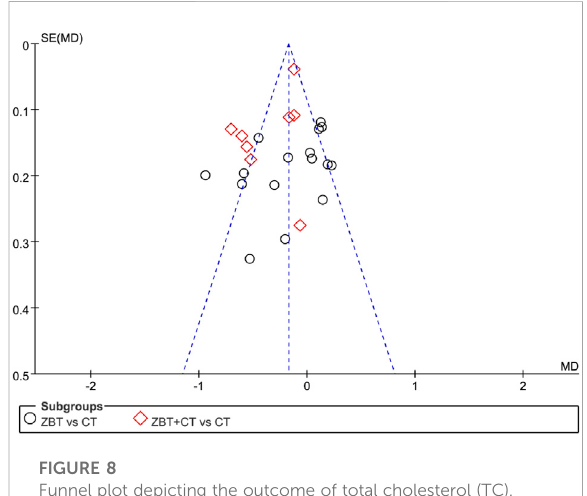
FIGURE 8 Funnel plot depicting the outcome of total cholesterol (TC). MD ,meandifference; se